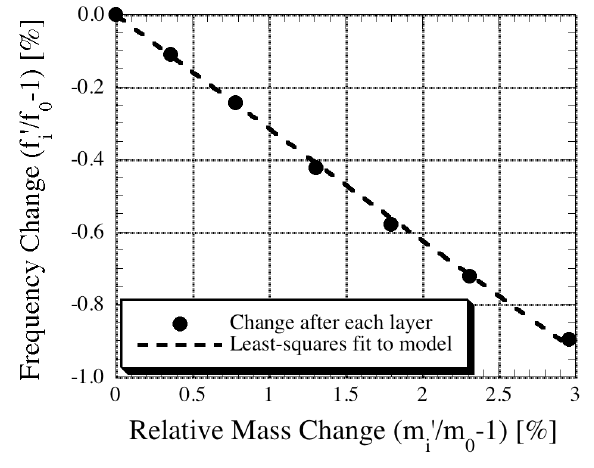
Figure 20. Relative frequency shift of a silver coated magnetoelastic sensor as a function of coating mass; the data was used to find the elastic constant of silver coating. Reprinted with permission from [18].